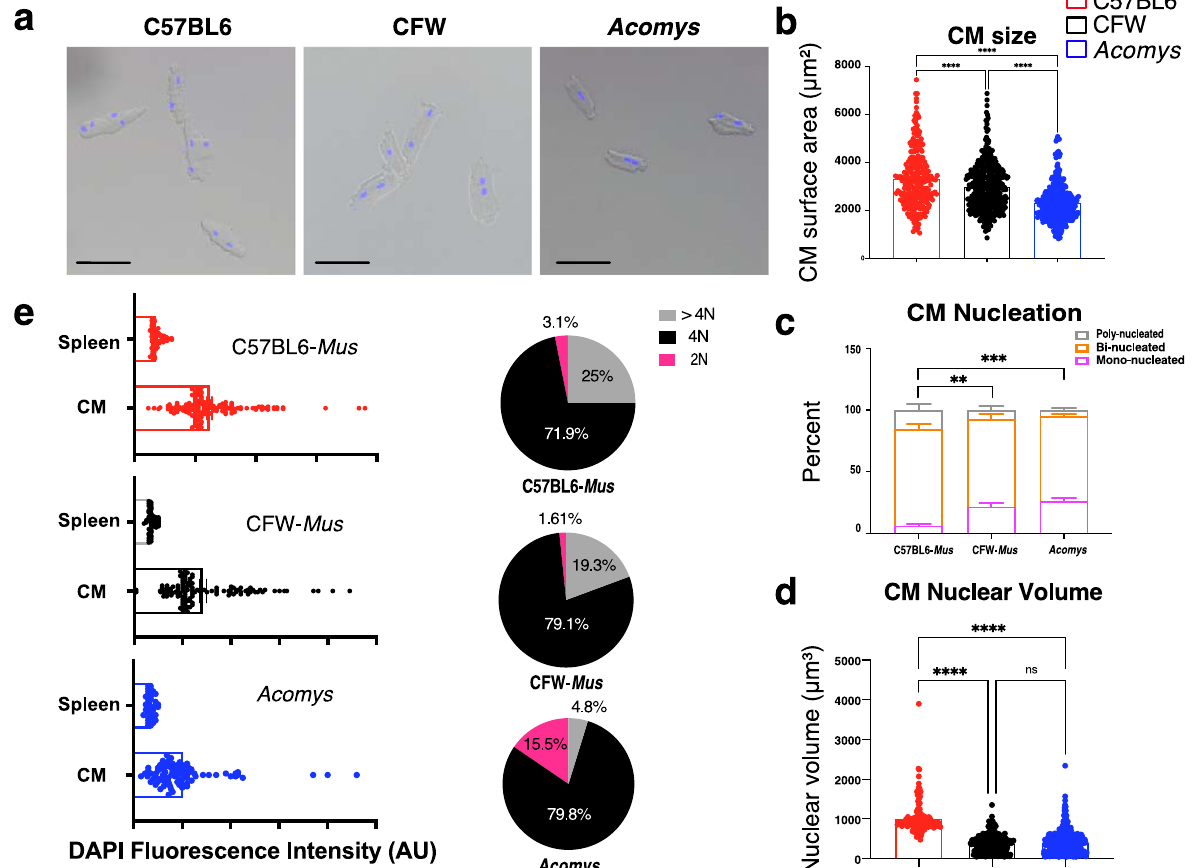
Fig. 2 Acomys cardiomyocytes exhibit features associated with Mus immature cardiomyocytes. a Representative images of single-cell ventricular suspension stained with DAPI (blue), identifying small, mononuclear, and binucleated cardiomyocytes in Acomys and larger binucleated cardiomyocytes in Mus -C57BL6 with Mus -CFW cardiomyocytes being intermediate in size (scale bar = 50 μ m) with mononuclear and binucleated cardiomyocytes. b Quantitative analyses of cell surface area of Mus and Acomys ( n = 80 – 120 randomly selected CMs/animal and N = 4 each for Mus -C57BL6, Mus -CFW, and Acomys , *** P < 0.001 by one-way ANOVA; values are means ± S.E.M). c Percentage of mono-, bi- and poly-nuclear cardiomyocytes in C57BL6-, CFW- Mus and Acomys ( n = 80 – 120 randomly selected CMs/animal, N = 4 mice for each group, values are means ± S.E.M, ** P < 0.01, *** P < 0.001 by One-way ANOVA and Dunnett ’ s post-hoc analysis, compared to C57BL6- Mus ). d Nuclear volume among isolated cardiomyocytes showing small nuclear volume in CFW- Mus and Acomys compared to C57BL6- Mus ( n = 80 – 120 randomly selected CMs/animal, N = 4 mice per group, values are means ± S.E.M, *** P < 0.001 by One-way ANOVA and Dunnett ’ s post-hoc analysis, compared to C57BL6- Mus ). e Violin plots, on left, demonstrating the distribution of DAPI fl uorescence intensity in cardiomyocyte nuclei as assessed using Imaris on 3D (Z-stack) microscopy images. The right panel shows the percentage of CMs within each ploidy category from the total pool of CMs from each species (2N, 4N, and > 4N); n = 84 – 161 randomly selected